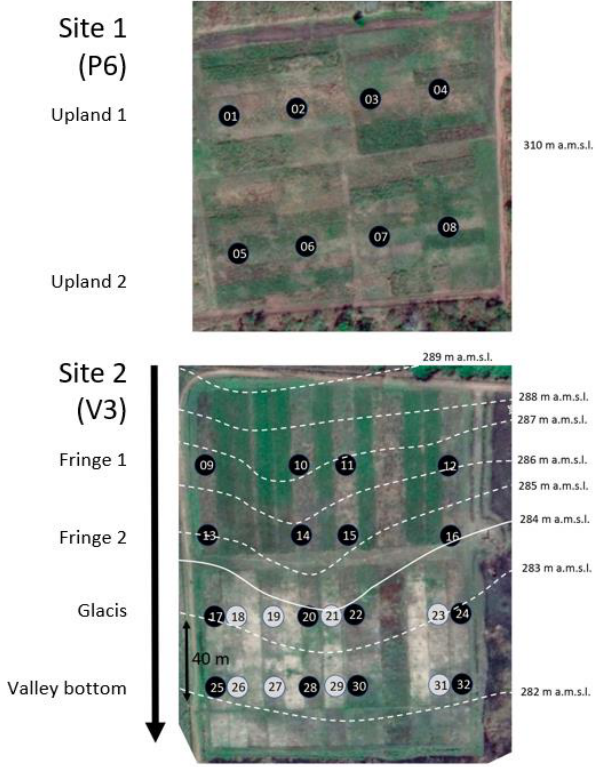
Figure 2. Sampling points and measurements.